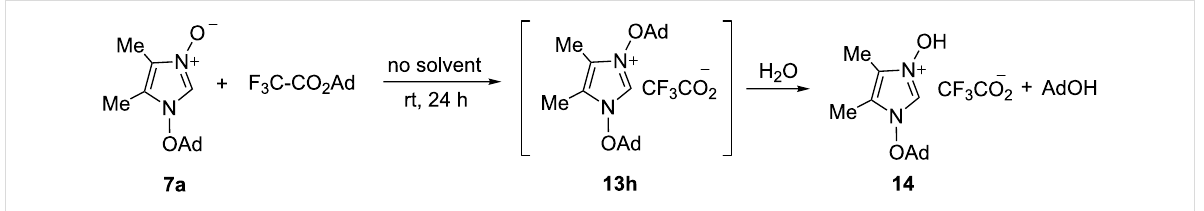
Scheme 7: Attempted O -adamantylation of imidazole N -oxide 7a with adamantan-1-yl trifluoroacetate and subsequent hydrolysis of the initially formed imidazolium salt 13h .